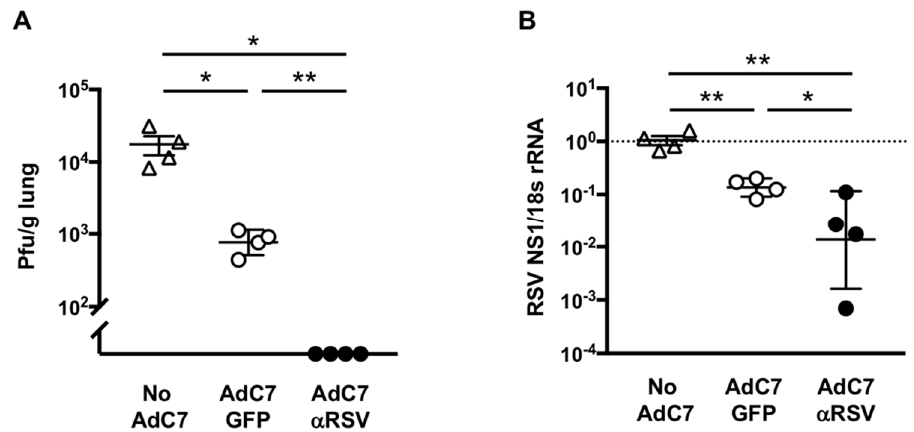
Figure 5. Protection against RSV infection following AdC7 α RSV administration to adult mice.